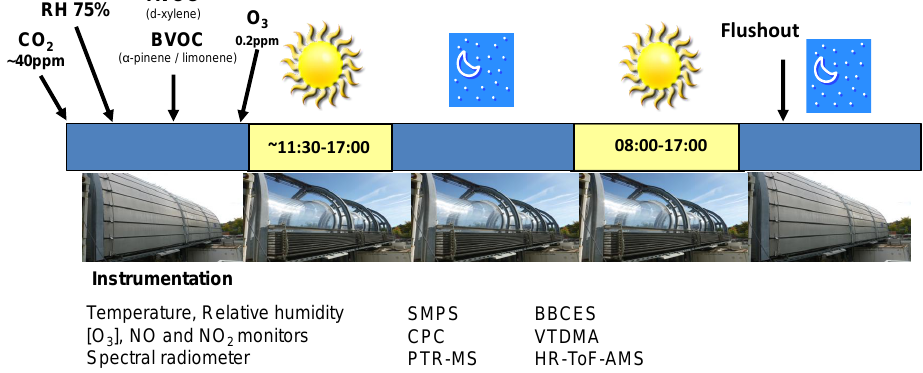
Figure 1. Schematic of the experimental procedure and instrumentation used for measuring the evolution of secondary organic aerosol over a diurnal cycle. All experiments began around 11:30 local time. Acronyms: SMPS – scanning mobility particle sizer; CPC – condensation particle counter; PTR-MS – proton transfer reaction mass spectrometer; BBCES – broadband cavity-enhanced spectrometer; VTDMA – volatility tandem differential mobility analyzer; HR-ToF-AMS – high-resolution time-of-flight aerosol mass spectrometer. Table 1. Description of the experiments performed in this study.